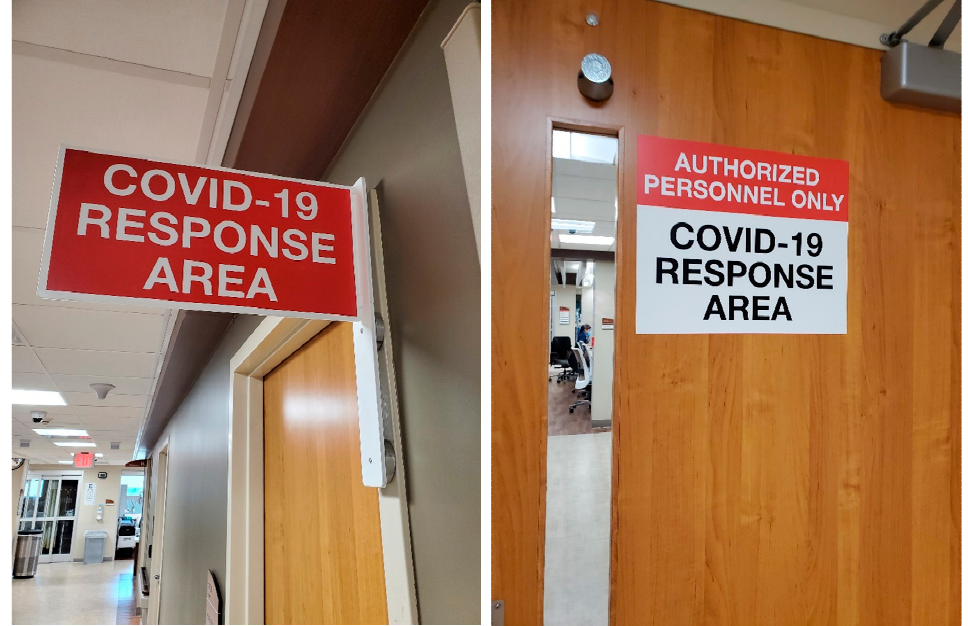
Figure 1. “COVID-19 RESPONSE AREA” signage on the doors.